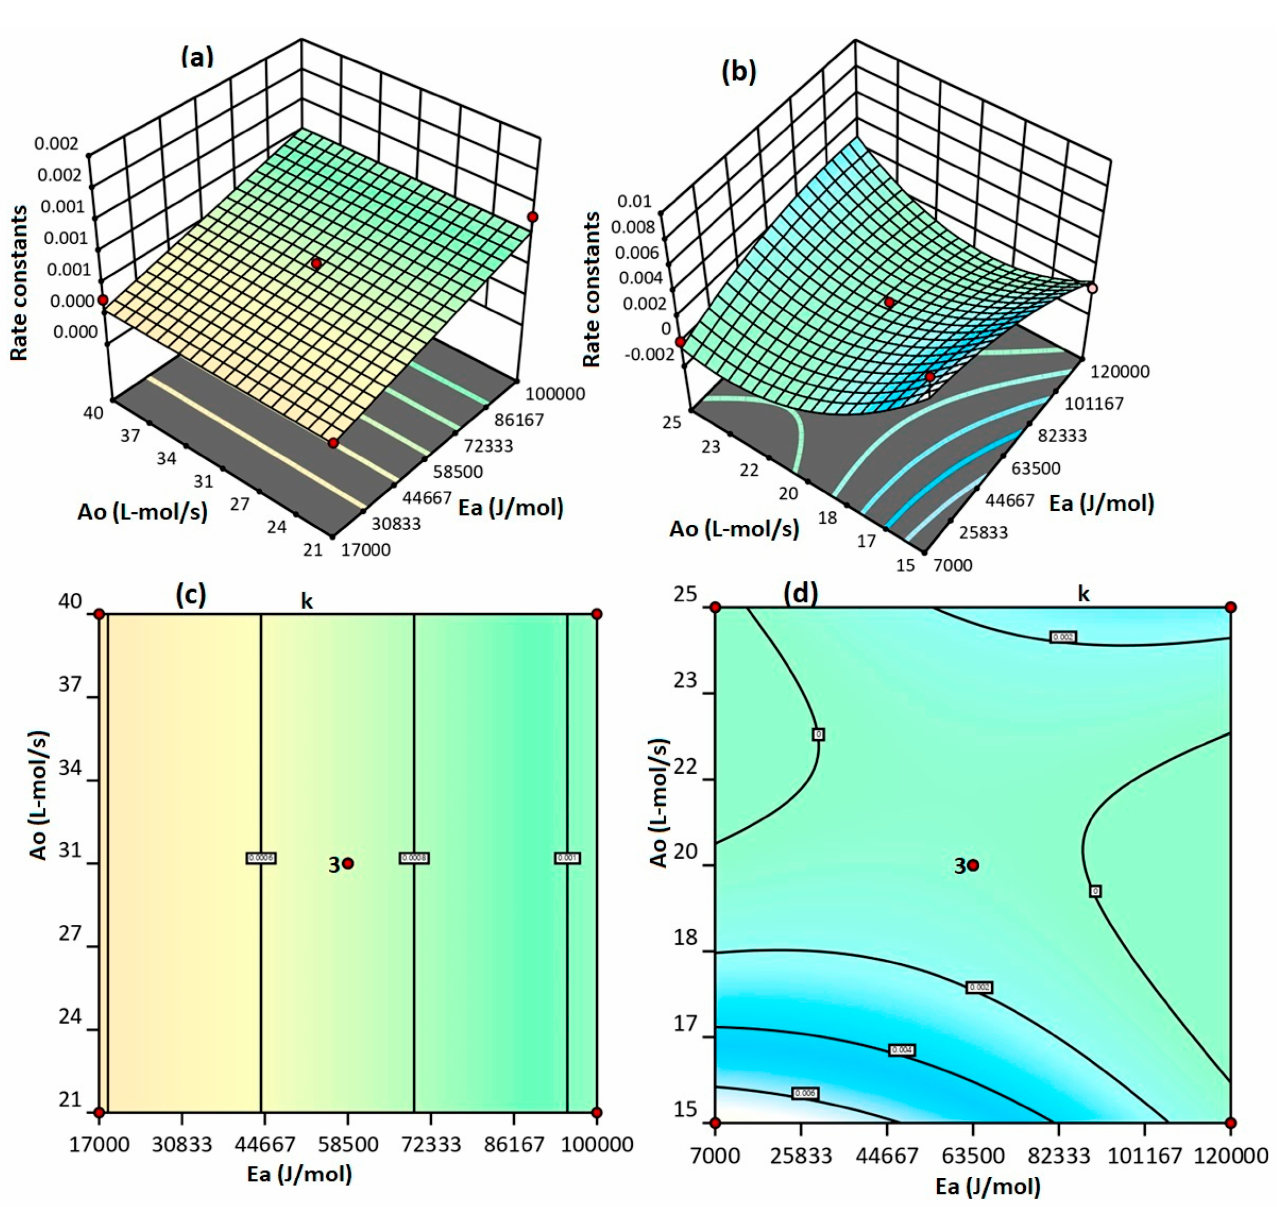
Figure 3. Predictedsevenrate constants for each model: ( a ) 3D verification of the predicted rate constants at 500 ◦ C. ( b ) 2D confirmation of the predicted rate constants at 500 ◦ C. ( c ) 3D verification of the predicted rate constants at 550 ◦ C. ( d ) 2D verification of the predicted rate constants at 550 ◦